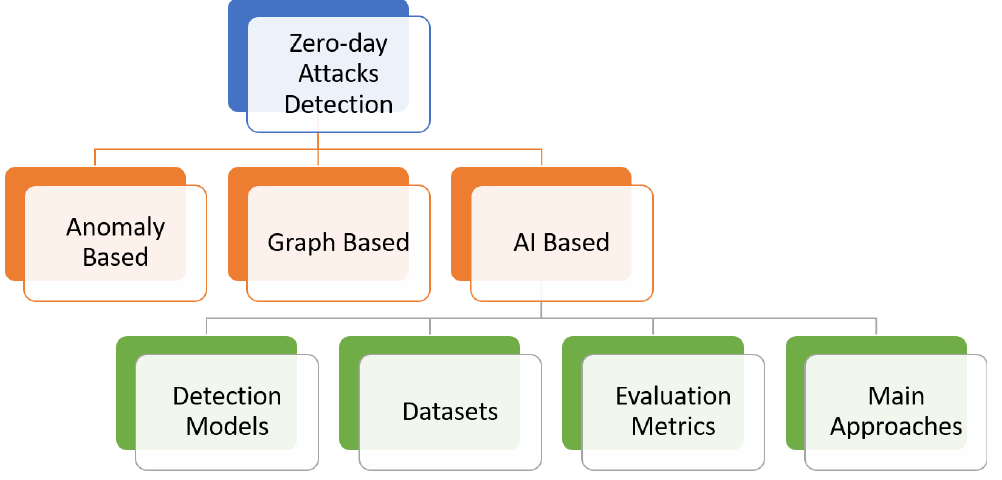
Figure 3. Zero-day attack detection